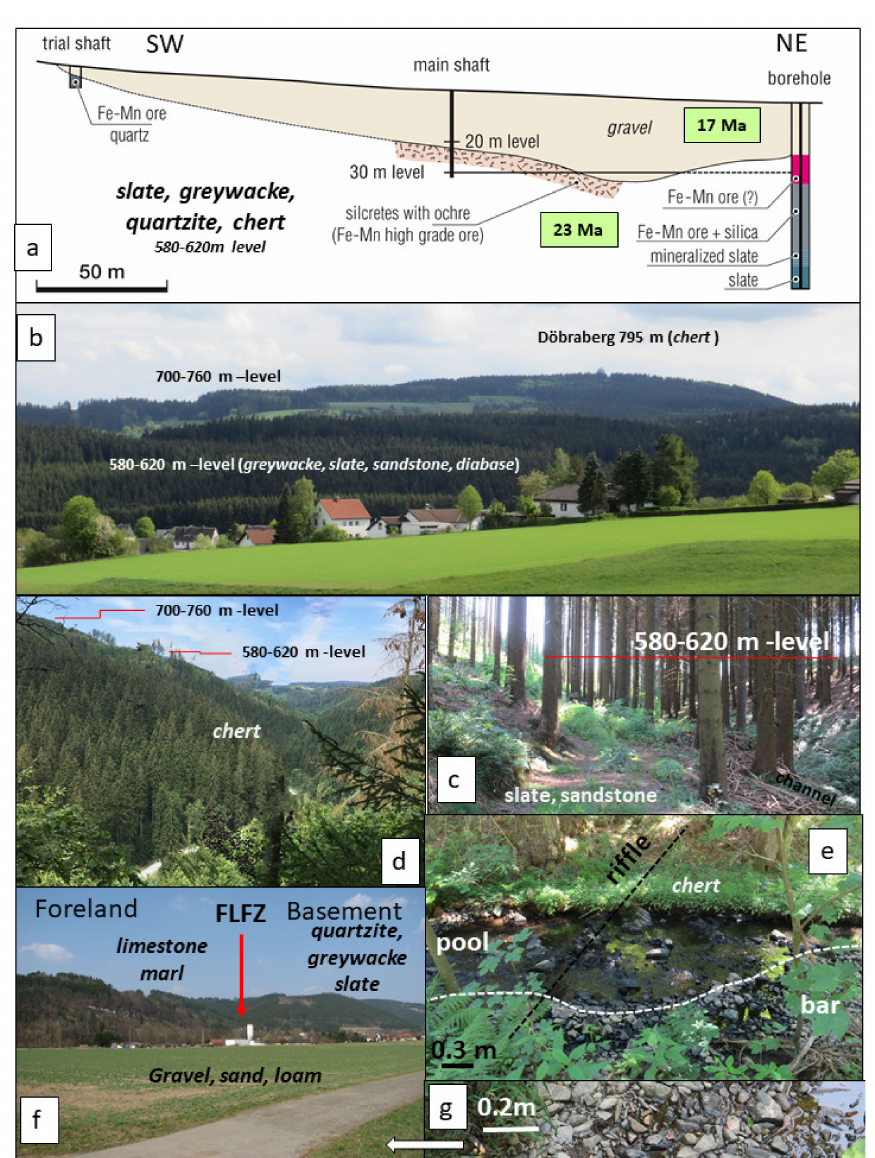
Figure 6. Fluvial landforms from the CA, TA and DA of the VLG-type (Table 1). For peneplains, erosional and depositional terraces, and floodplains see Figure 3. ( a ) Wide-and-shallow valley of the proto-drainage system (peneplain in the CA) filled with coarse-grained alluvial-fluvial deposits and Fe-Mn ore. The age of formation of the cryptomelane at the bedrock-valley floor and as cement are given in green boxes. ( b ) The monadnock of the Döbraberg representative of a relic peneplain in the CA. A wide-and-shallow valley in the foreground (see also ( a )). ( c ) Wide-angle single-channel alluvial V-shaped valley evolved in loamy regolith near the watershed (slope angle 15 ◦ ⇒ 20 ◦ , talweg angle 3.3 ◦ ⇒ 1.2 ◦ ). ( d ) Incision of the acute-angle single-channel non-alluvial V-shaped valley of the Wilde Rodach into the Neogene peneplains (slope angle 30 ◦ ⇒ 35 ◦ , talweg angle 2.7 ◦ ⇒ 0.7 ◦ ) (photograph by courtesy of H. Schmalfuss). ( e ) Close-up view of the channel of ( d ) with steps and pools in Devonian chert (stippled white line = strike of bedding) and the onset of wandering channels to evolve. ( f ) Transition from the TA into the DA while crossing the Franconian Lineamentary Fault Zone (FLFZ) between the uplifted basement and the foreland at the 440–500 m level (modern floodplain = 340 m). A U-shaped valley with steep slopes and wide flood plain evolved between paired terraces (slope angle/ basement 30 ◦ ⇒ 35 ◦ , talweg angle 0.3 ◦ ⇒ 0.2 ◦ ), in places > 35 ◦ ; slope angle/ foreland 25 ◦ ⇒ 30 ◦ , talweg angle 0.2 ◦ ⇒ 0.3 ◦ ). ( g ) Close-up view of the flood plain deposits (mainly greywacke, quartzite) of ( f